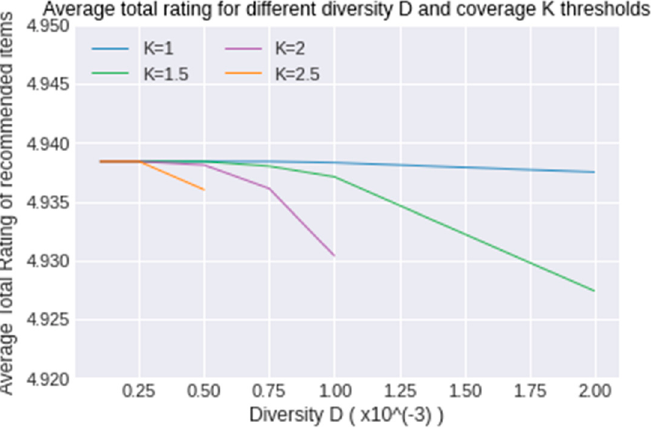
Figure 3. Average rating for different values of diversity and coverage.